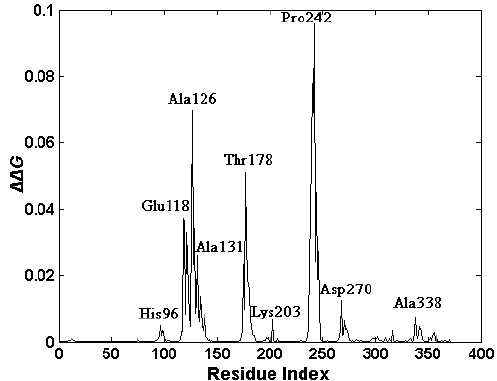
Figure 8. ΔΔ G values in response to residual perturbations. The residues of the clusters with peak values are marked.